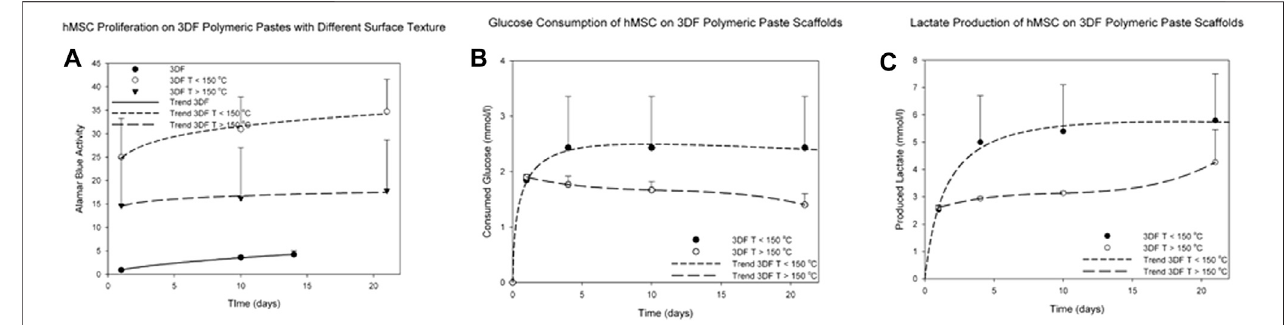
FIGURE 4 | Metabolic activity of hMSCs cultured for up to 21 days on 300/55/45-PVP paste scaffolds. (A) The metabolic activity was signi fi cantly higher on the paste scaffolds than on smooth scaffolds (thermoplastic polymers). (B) Glucose consumption and (C) lactate production were measured on 300/55/45-PVP paste scaffolds, indicating a higher glucose consumption and lactate production levels on scaffolds sintered at temperatures lower than 150 ° C.